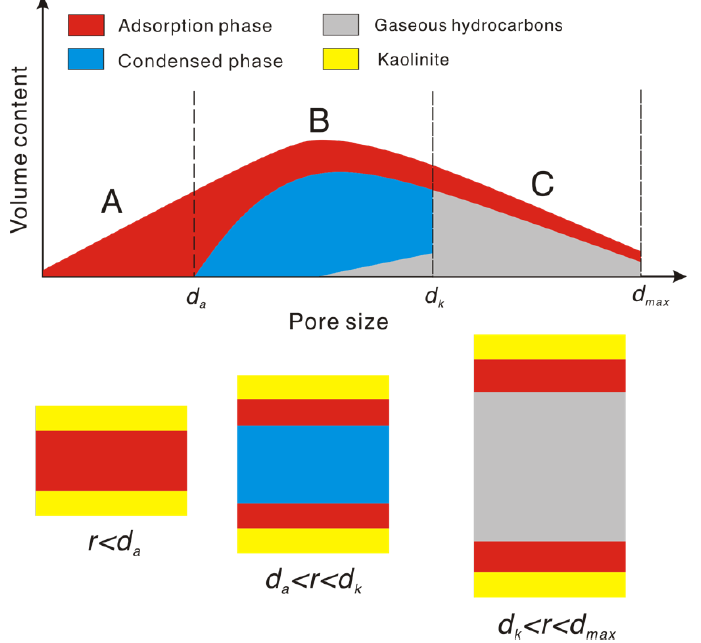
Figure 9. Occurrence of n-pentane in various pores of kaolinite by hydrocarbon vapor adsorption. d a , d k , and d max divide the pores of kaolinite into three zones (A, B, and C). d a is twice the thickness of the adsorption layer. d k determines the interval in which vapor coalescence occurs, which can be calculated from the Kelvin radius r k . d max is the maximum pore size of kaolinite.